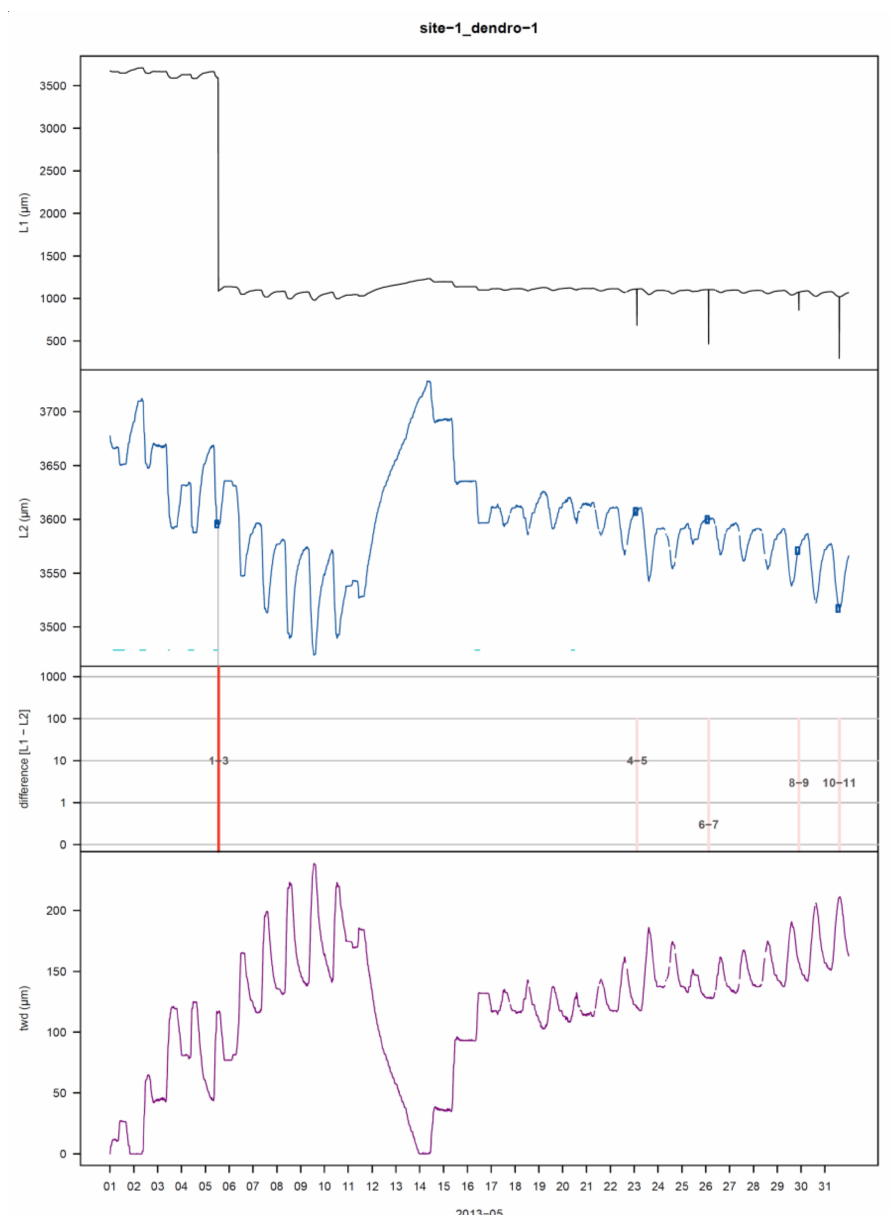
Figure 3. Visualisation plot of the function proc_dendro_L2 with argument plot_period = “monthly”. The first panel shows the stem radius changes of time-aligned dendrometer data (L1). The second panel shows cleaned L2 data. Horizontal cyan lines at the bottom of the panel indicate potential frost periods. Blue circles indicate interpolated data points. The third panel shows the correction-induced differences between L1 and L2 data (red) on a logarithmic scale. Erroneous, deleted values are shown with pink lines without a relevant scale (set to 100). Every change to the data gets an ID and facilitates the functions for manual corrections. The last panel shows the tree-water deficit